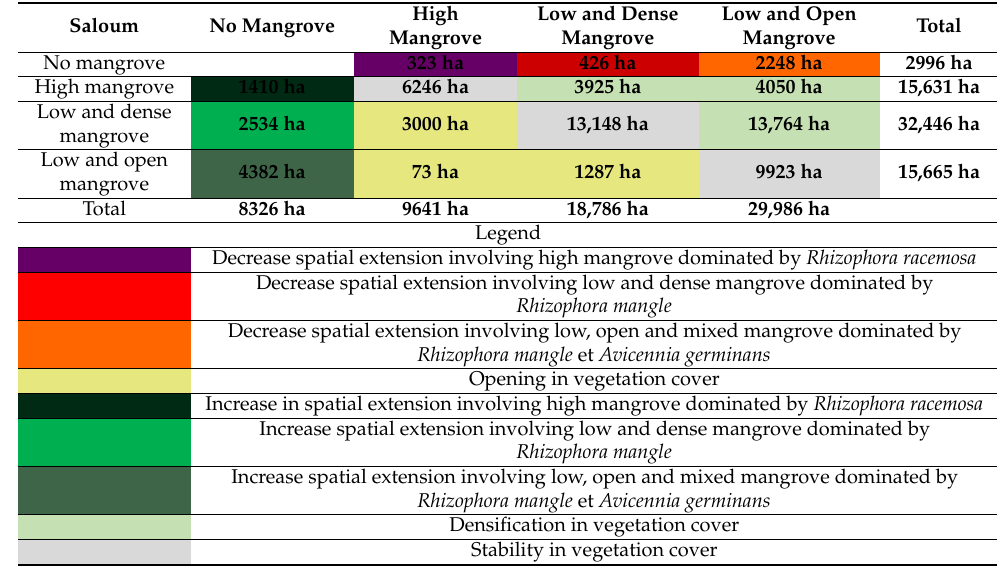
Table 7. Transition matrix for the mangrove zonation class in Saloum.